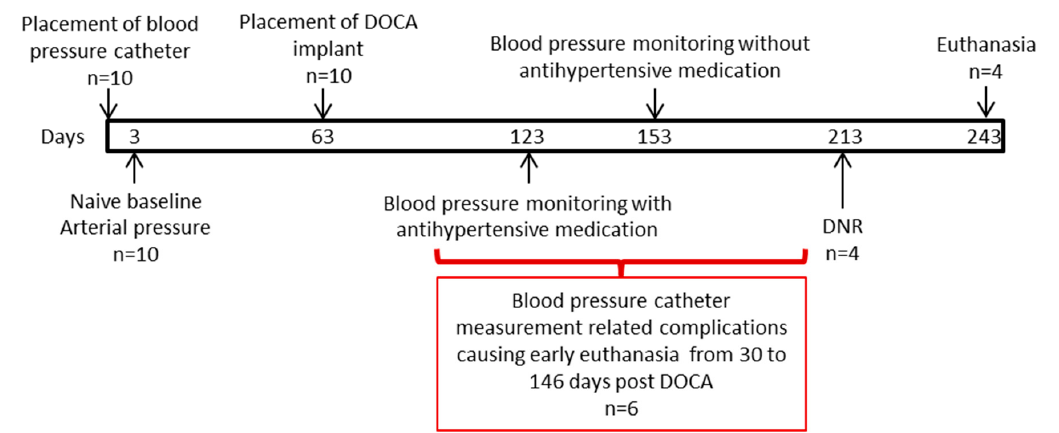
Figure 1. Scheme of study design.